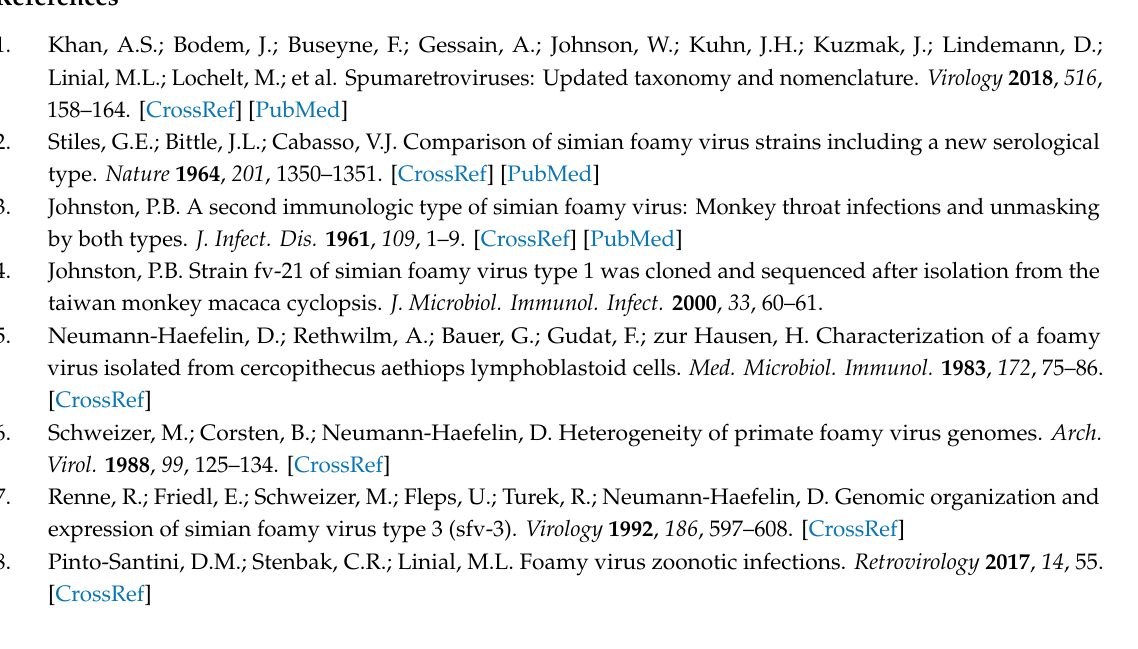
Figure S1. Nucleotide sequence alignment of SFVcae_FV2014 and SFVcae_LK3. Sequences were aligned using EMBOSS Stretcher version 6.6.0 using default parameters (http: // www.ebi.ac.uk / Tools / psa / emboss_stretcher / help / index-nucleotide.html). Nucleotide positions are indicated. Vertical lines indicate identical bases and dots indicate di ff erent bases. The LTRs, gag , pol , env , tas , and bet regions are indicated. The TATA, poly A + signal, and poly A + sites are underlined in the LTRs. The 3 nucleotides for the start and termination codons of genes are shown in red. The TATA in tas is underlined and the start site of the internal promoter (IP) is indicated by an arrow. The regulatory signals are indicated based upon homology to the SFVcae_LK3 sequence